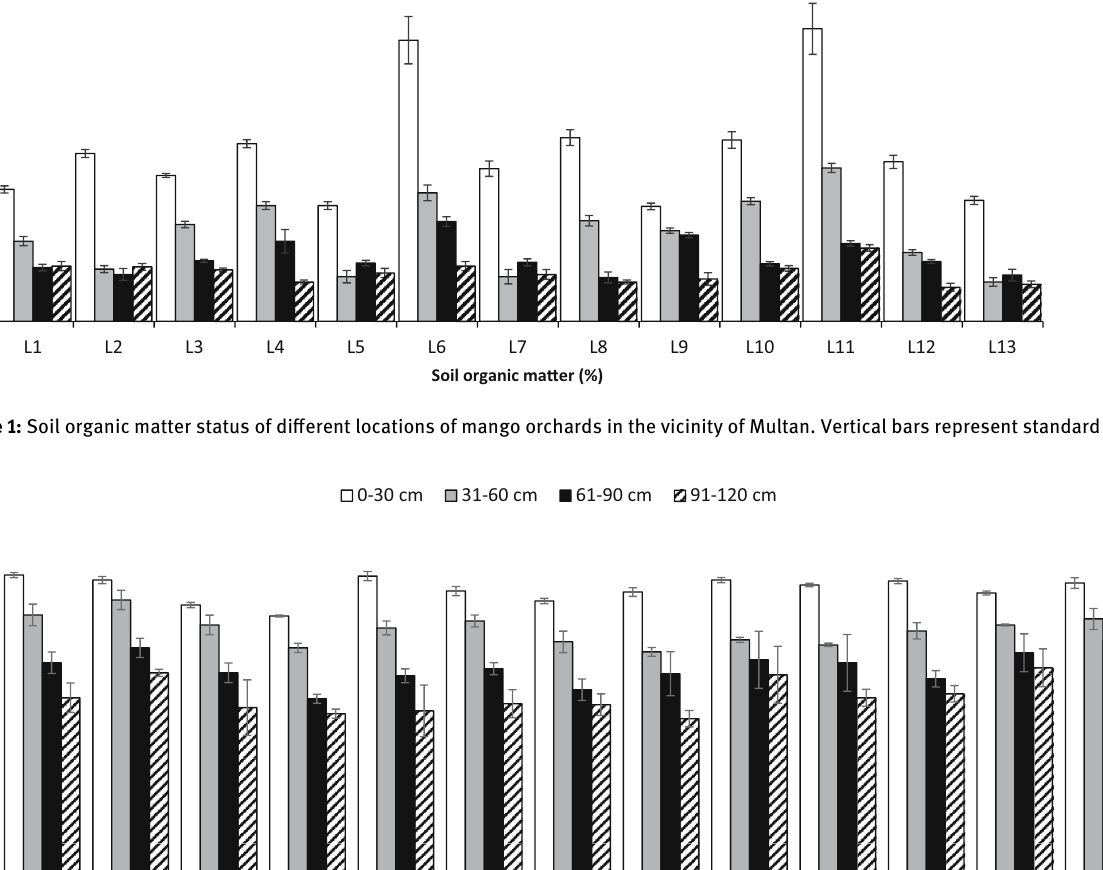
Figure 2: Soil potassium contents of di ff erent locations of mango orchards in the vicinity of Multan. Vertical bars represent standard